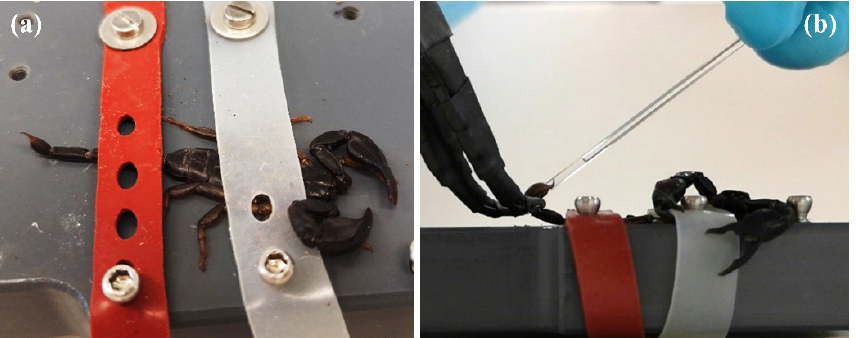
Figure 5. Venom extraction from E. italicus . ( a ) Fixation of specimens with rubber tubes. ( b ) Application of electricity with modified pincers and collection of released venom into glass capillaries.